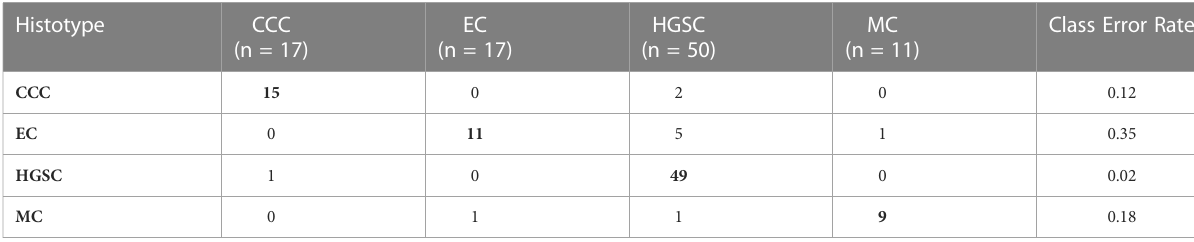
TABLE 2 Confusion matrix demonstrating Random Forest classi fi cation of ovarian carcinoma histotypes using RNA sequencing data (training cohort, n=95). Histotype